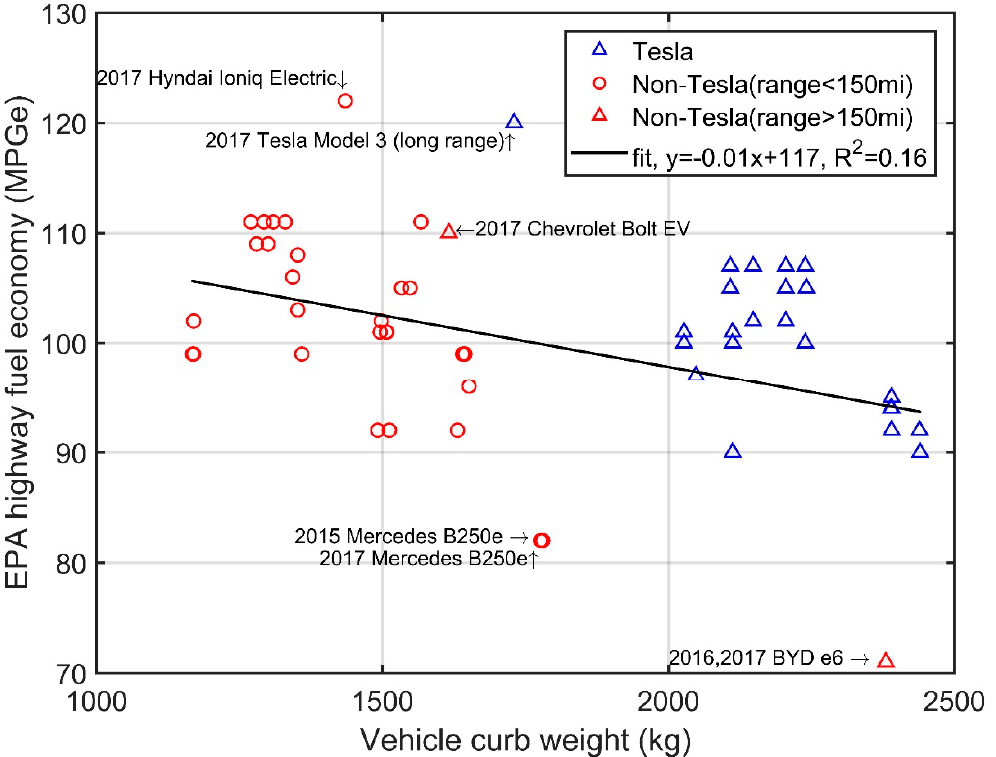
Figure 3. Scaling trend of EPA highway fuel economy (MPGe) with vehicle curb weight (kg). Blue represents Tesla vehicles, red represents non-Tesla vehicles, circle represents short-range BEV, and triangle represents long-range BEV.